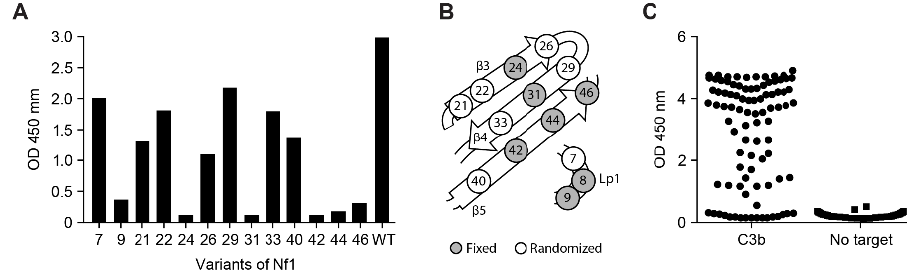
Figure 3. ( A ) Binding capacity on C3b of Nf1 alanine variants at 100 nM in ELISA (n = 1), ( B ) schematic Nf1 residues randomized for affinity maturation, and ( C ) ELISA screening of the variants of Nf1 resulting from the affinity maturation (n = 1). Nf, Nanofitin; OD, optical